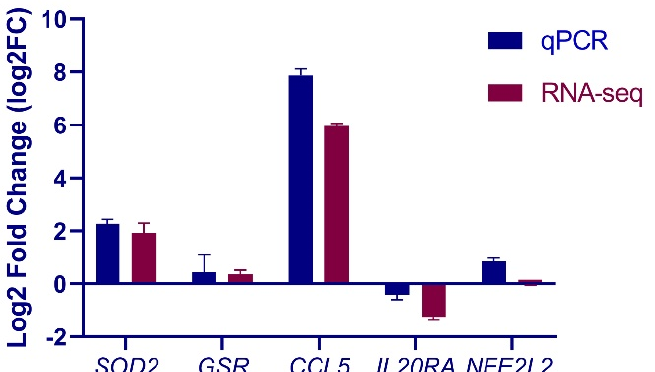
Figure 4. Real-time quantitative PCR (qPCR) validation of RNA sequencing (RNA-Seq) data. Relative mRNA abundance of Nrf2 , Chemokine (C–C motif) ligand 5 ( CCL5 ), glutathione reductase ( GSR1 ), superoxide dismutase 2 ( SOD2 ) and interleukin 20 receptor alpha ( IL20RA ) in E. coli -stimulated cells determined by RNA-seq and qPCR measurements. Results are expressed as log2FC over unstimulated control cells. Data are mean ± s.d. of triplicates.